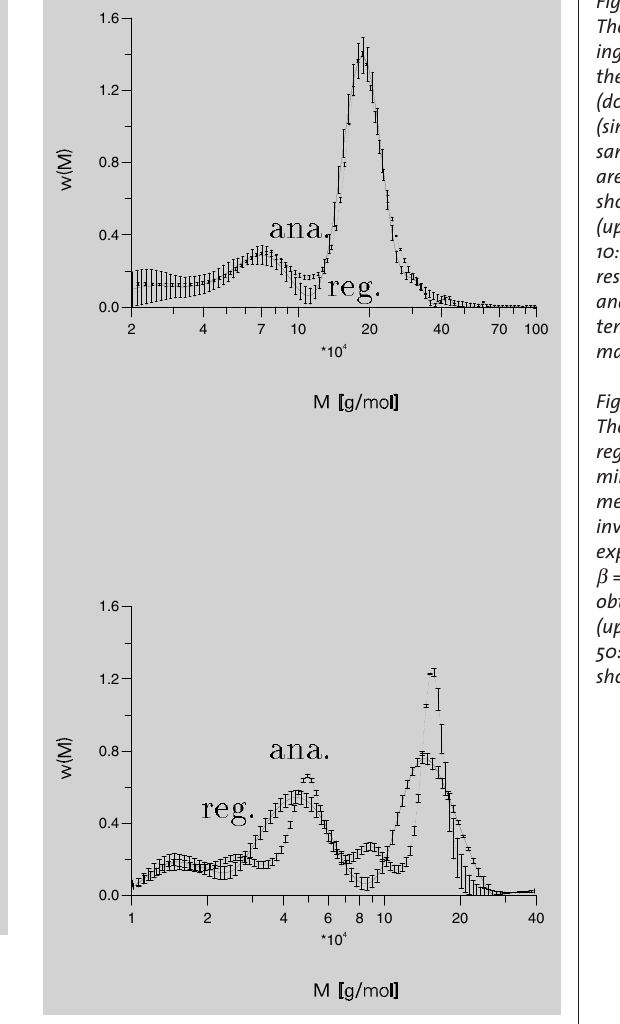
Figure 5a (left): The results obtained regard- ing the MWD determined by the analytical method (dotted) and the inversion (single exponential kernel, same β = 3.2) method (solid) are similar. Results are shown from iPP 70:30 (upper picture) and iPP 10:90 (lower picture). The results obtained with the analytical method do not tend to zero for smaller masses. Figure 5b (right): The results are obtained regarding the MWD deter- mined by the analytical method (dotted) and the inversion method (single exponential kernel, same β = 3.84) (solid). The results obtained for PS 80:20 (upper picture) and PMMA 50:50 (lower picture) are